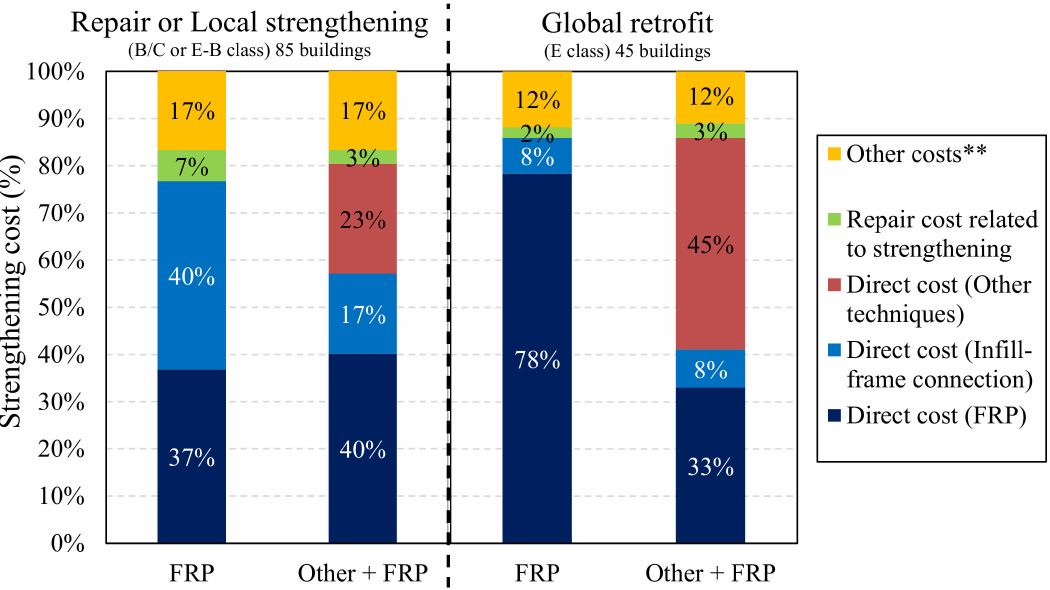
Figure 4. Distribution of the strengthening costs for different categories. (** This includes general costs for installing the construction field, safety measures, and professional fees related to strengthening